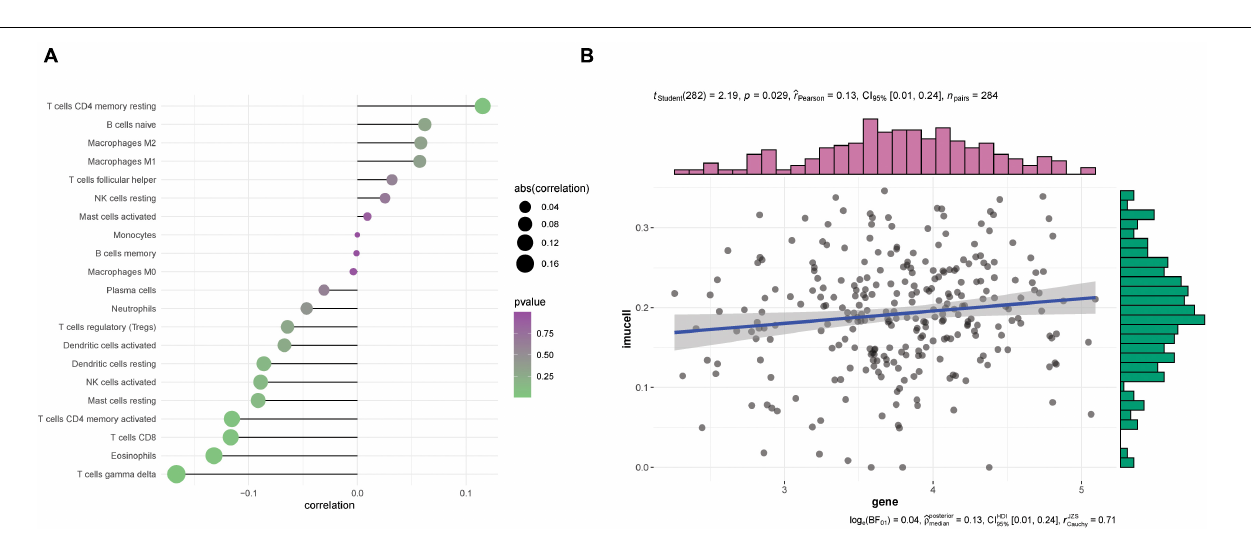
FIGURE 5 | GO and KEGG pathway enrichment analysis of 69 genes in dark green module selected by WGCNA. (A) The most significantly enriched pathways of the selected 69 genes ( P < 0.05). (B) Network showed pathways enriched of the selected 69 genes. Different colors of nodes represent different enrichment pathways.